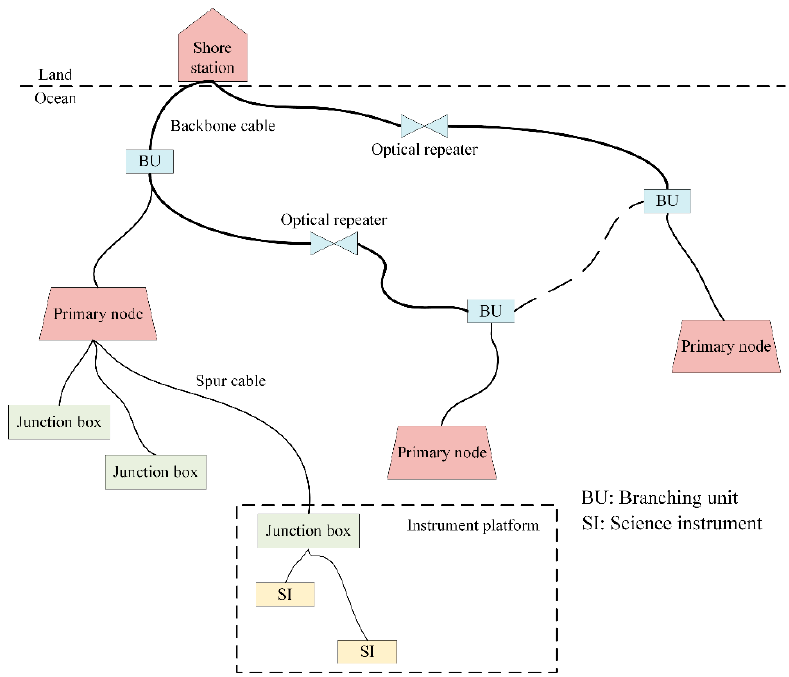
Figure 1. The system structure of seafloor observatories [4].